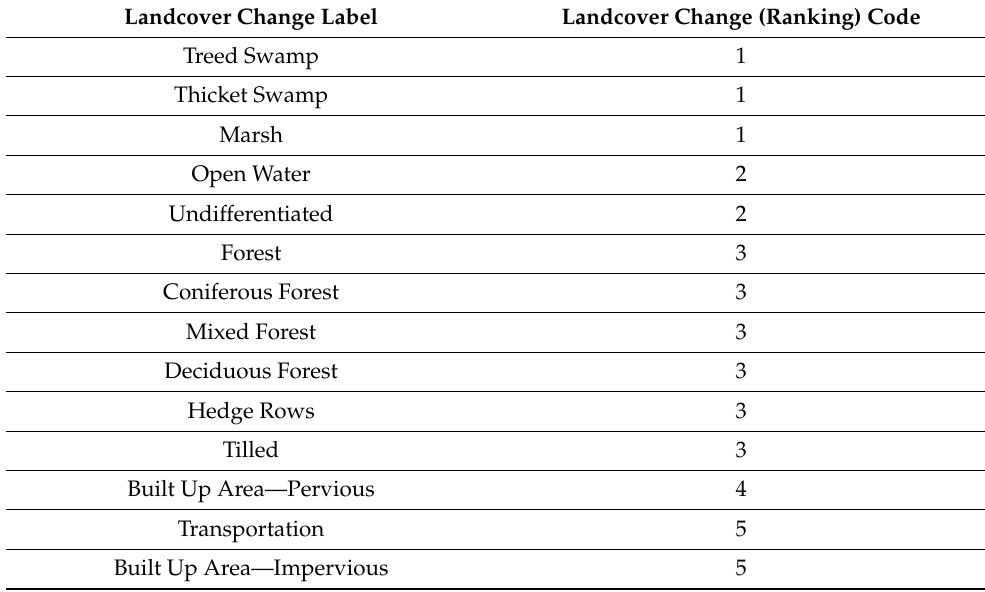
Table 1. Toronto landcover change ranking system.